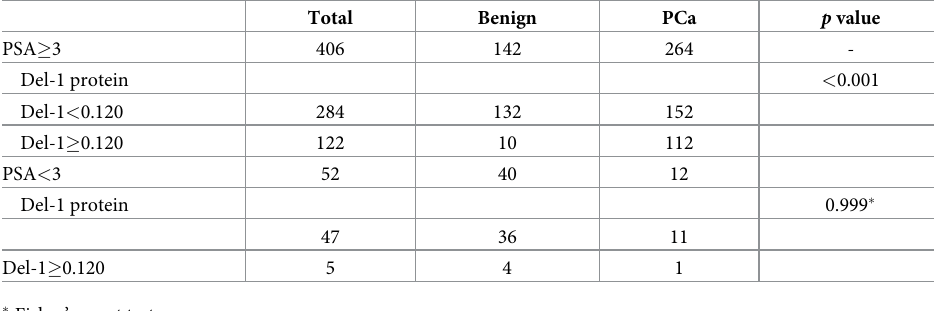
Table 2. Distribution of patients when cut-off value of Del-1 protein and PSA is 0.120 and 3.0.